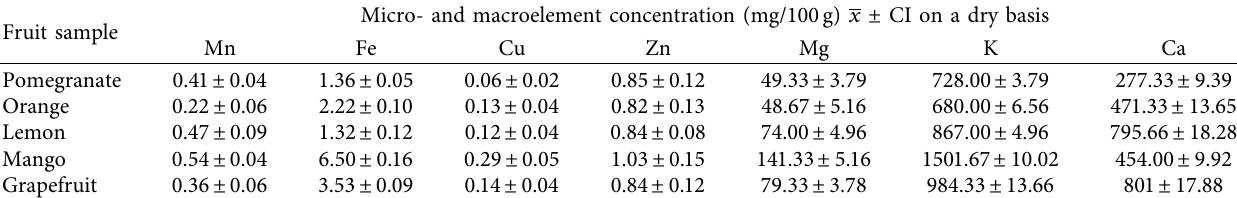
Table 8: Contents of micro- and macroelements in fruit peel samples using the UAE method. Fruit